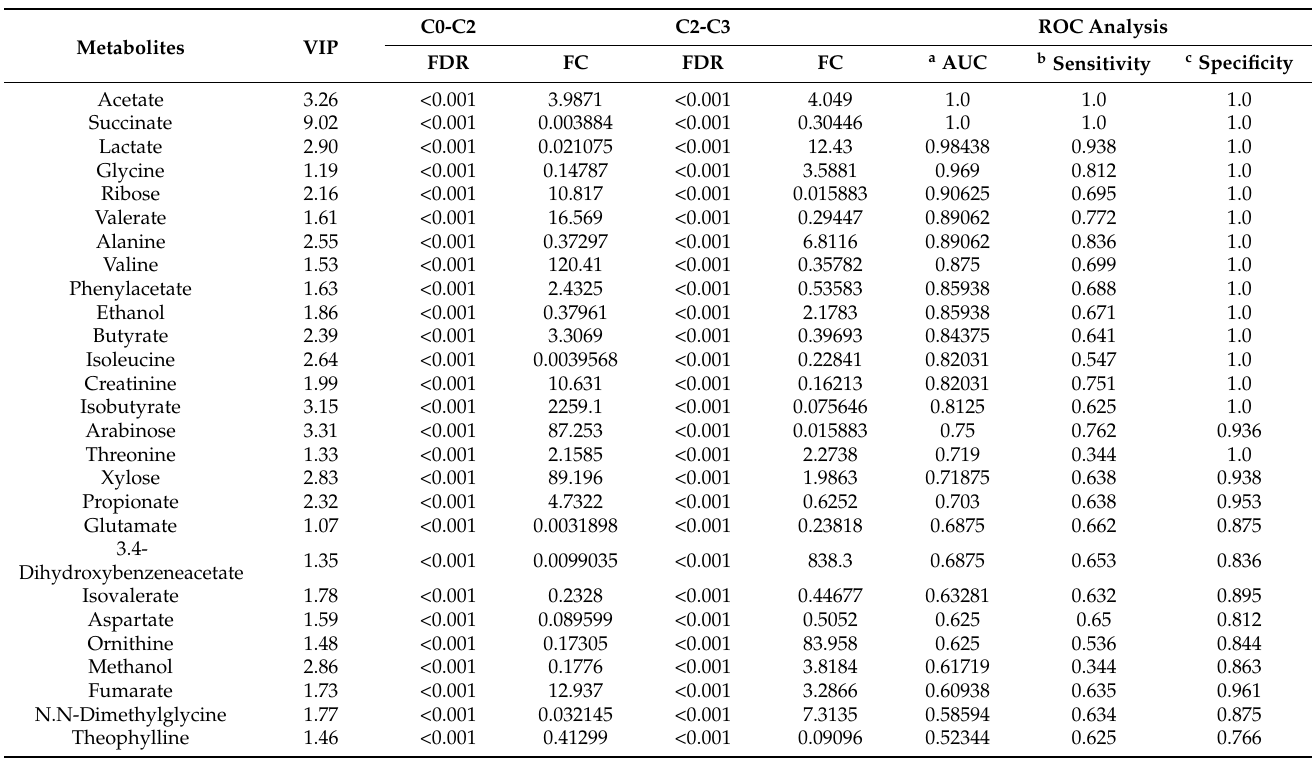
Table 3. Biomarkers identified in fecal metabolic profiles of breast cancer (BC) patients. a Area under the receiver operating characteristic (ROC) curve of the biomarkers; b sensitivity and c specificity were calculated from the ROC curve. Metabolites